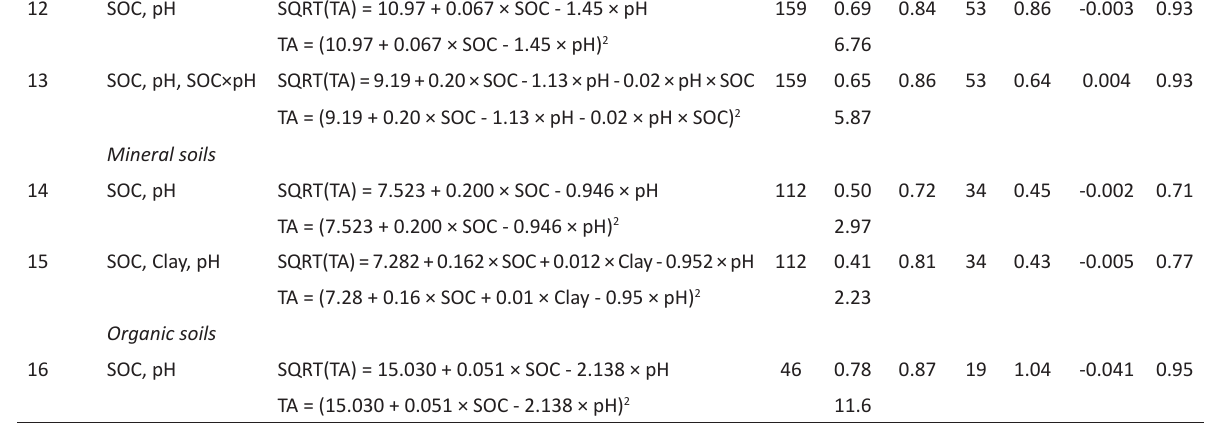
Table 8. Pedotransfer functions for estimating titratable acidity (TA, cmol(+) kg -1 ) using soil organic carbon (SOC, %), pH and clay content (%, for mineral soils) as explanatory variables, and statistics of calibration data and validation data TA Calibration Validation Eq. No. Predictors Regression equation